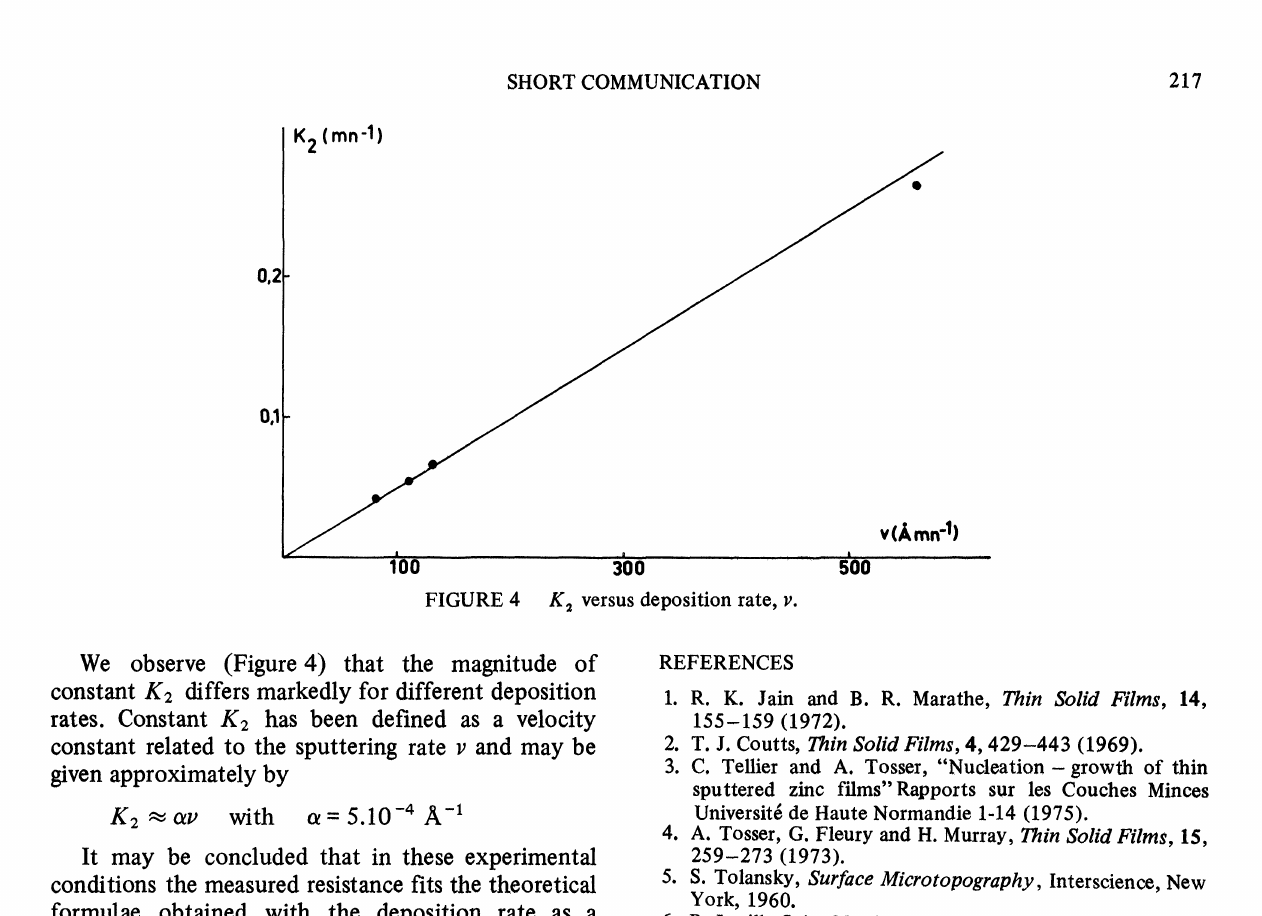
FIGURE 4 K versus deposition rate,